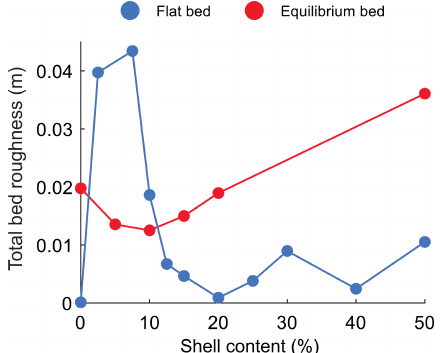
Figure 8. Total bed roughness against shell content for the flat beds (ACC flow experimental runs) and equilibrium beds (constant flow experimental